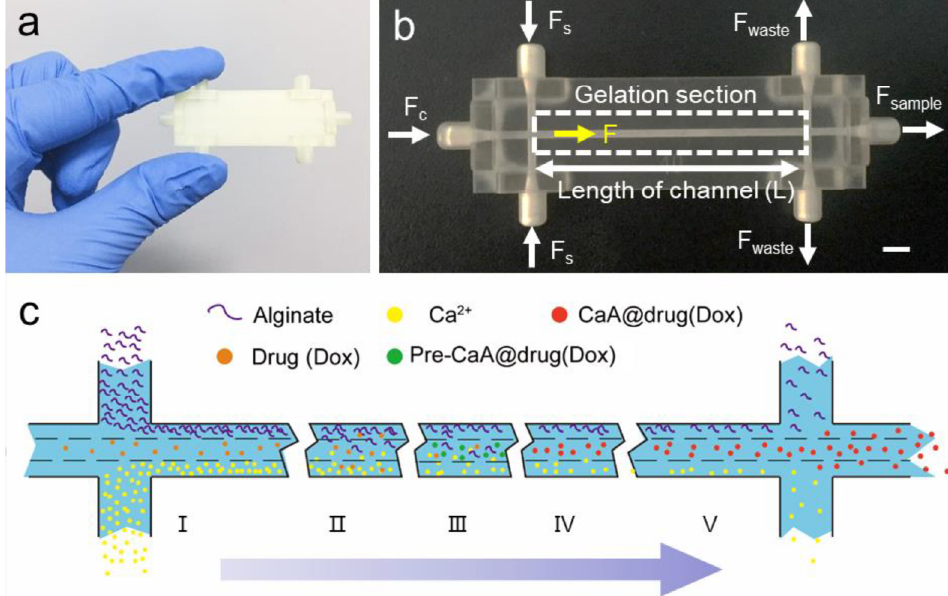
Figure 9. A 3D-printed concentration-controlled microfluidic chip for the synthesis of calcium alginate microgels and the diffusion mixing pattern. ( a ) Photograph of the 3D-printed concentration- controlled microfluidic chip. ( b ) Photograph of the 3D-printed concentration-controlled microfluidic chip of 30 mm. The F c represents the middle stream flow rate. F s represents the side stream flow rate. F represents the total flow rate in channels. F waste the flow rate of the waste solution and F sample is the flow rate of the sample. The scale bar is 3 mm. ( c ) Schematic representation of the diffusion mixing pattern where the large differential concentration drives the diffusion of alginate molecules and Ca 2+ ions into the central stream, and later gradually generating microparticles when traveling along the microchannels. The formation of products is divided into the following steps: entrance (I), diffusion (II), mixing (III), gelation (IV), and collection (V). Reproduced from